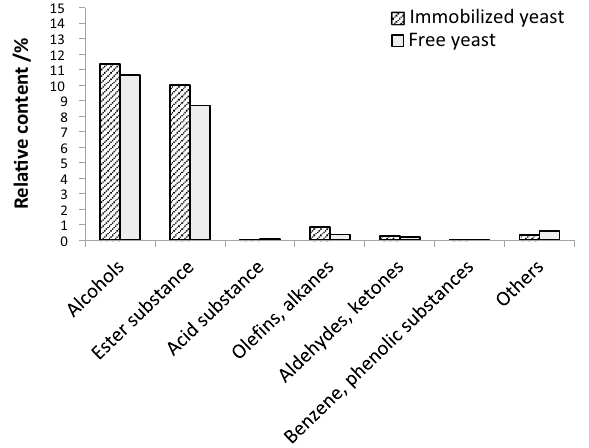
Figure 6. Aroma composition of red raspberry wine fermented with Immobilized yeast or free yeast.